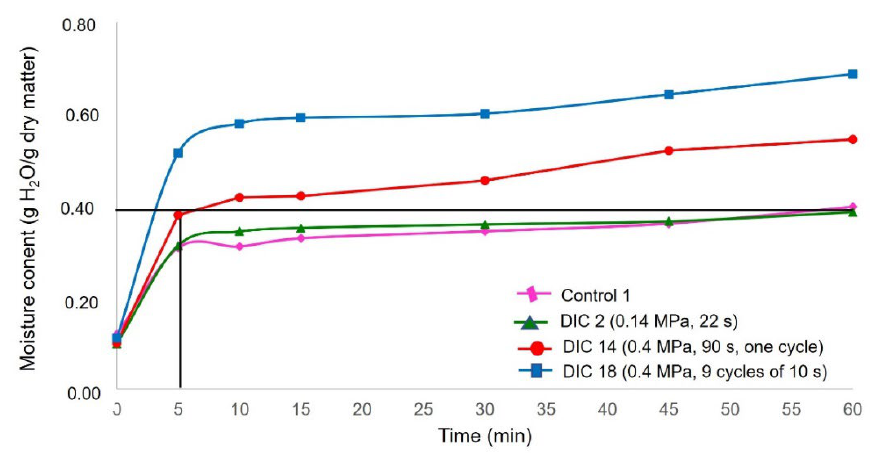
Figure 5. Rehydration curves of maize kernels: Control and DIC-CAD (P = 0.14 MPa, t = 22 s; P = 0.4 MPa, t = 90 s and P = 0.4 MPa, t = 90 s divided into nine cycles of 10 s).